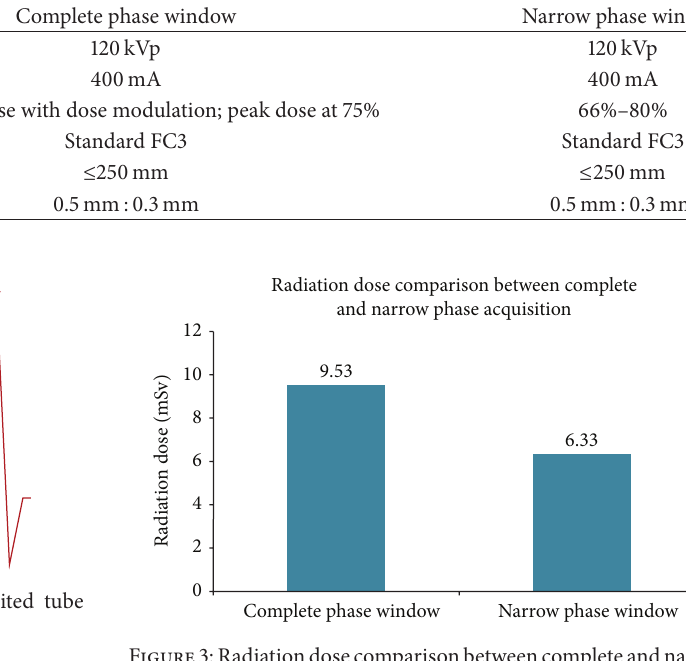
Table 2: Typical imaging and reconstruction parameters for complete versus narrow phase window acquisition at 320-row MDCTA.